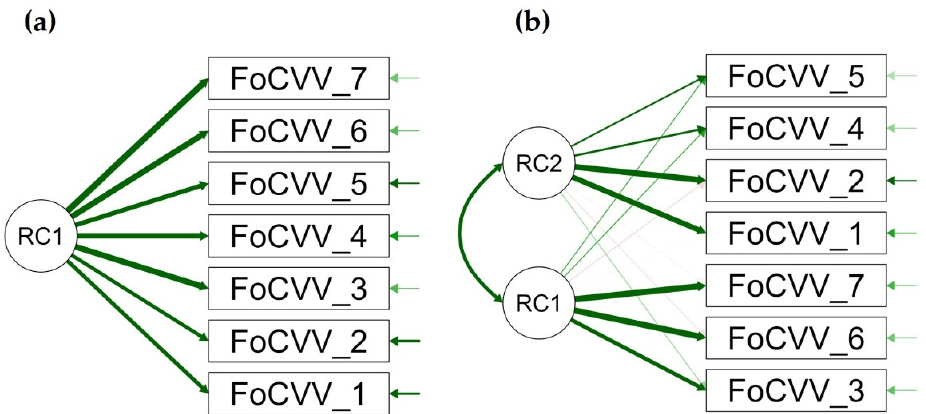
Figure 1. Path diagram for ( a ) Model 1 with a one-factor solution and ( b ) Model 2 with a two-factor solution of the fear of vaccination scale. FoCVV = item of the Fear of Coronavirus Vaccination, RC = rotated component.